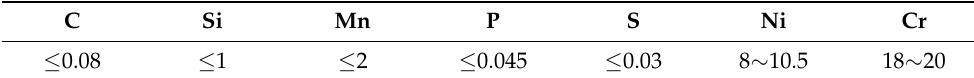
Table 1. Chemical compositions (wt%) of SUS304 stainless steel.